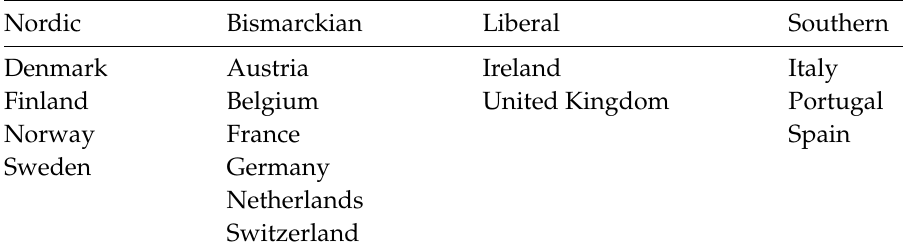
Table 1: Classification of Welfare State